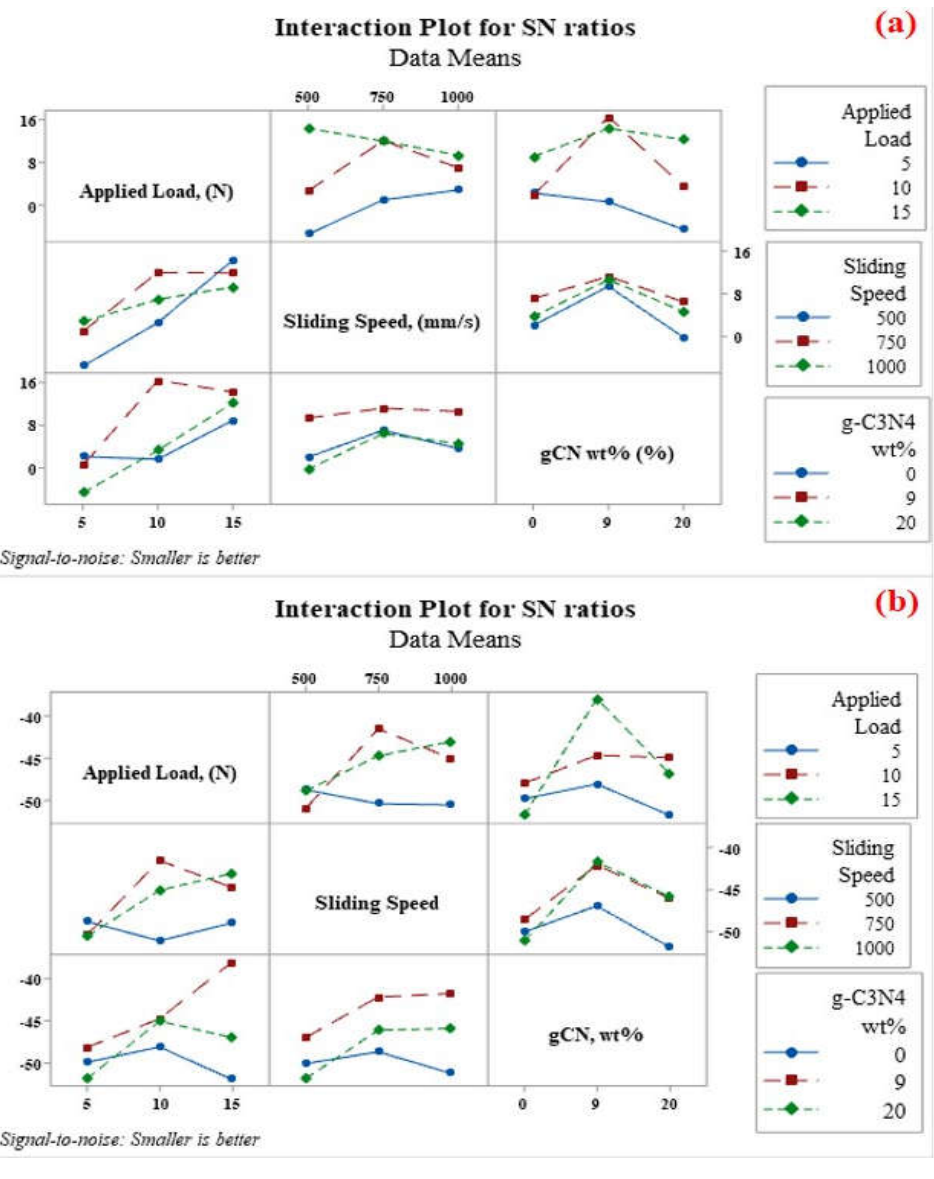
Figure 5. Interaction effect of load, sliding distance, and sliding speed on the wear rate of friction material at different operating conditions ( a ) COF and ( b ) wear depth